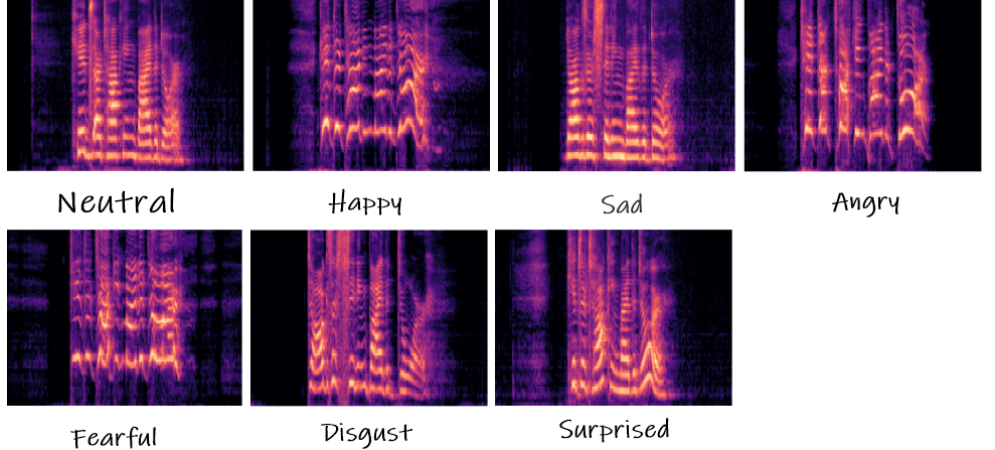
Figure 3. Mel spectrograms of vocal timbres selected from RAVDESS (Ryerson Audio–Visual Database of Emotional Speech and Song)